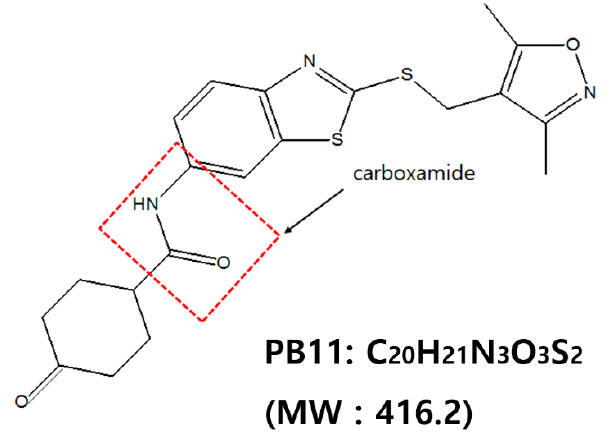
Figure 1. Chemical structure of N-[2-[(3,5-dimethyl-1,2-oxazol-4-yl)methylsulfanyl]-1,3-benzothiazol-6-yl]-4-oxocyclohexane-1-carboxamide (PB11, MW: 416.2).